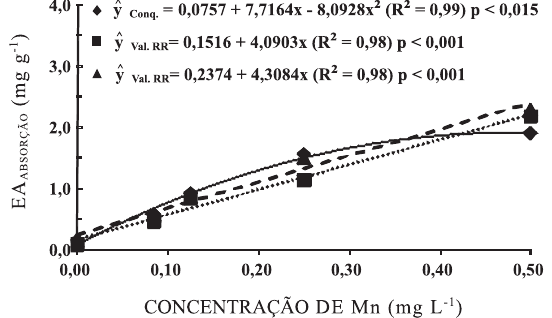
Figura 3. Eficiência de absorção (EA) de Mn das cultivares Conquista e Valiosa RR com e sem aplicação de glifosate via foliar, em função de doses de Mn na